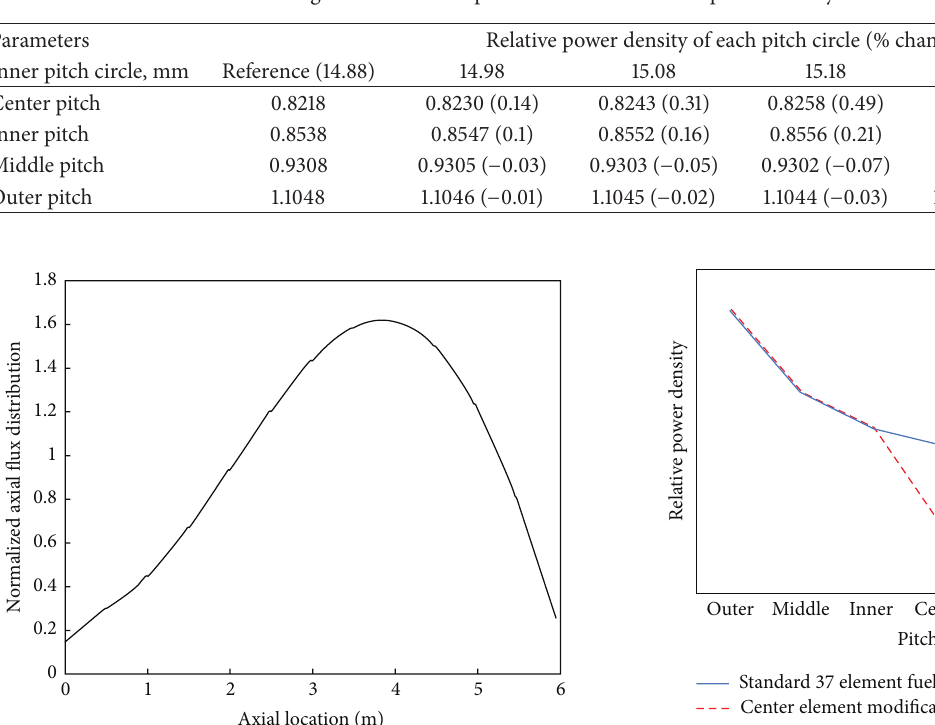
Table 2: Length effect of inner pitch circle on the relative power density of the fuel elements.